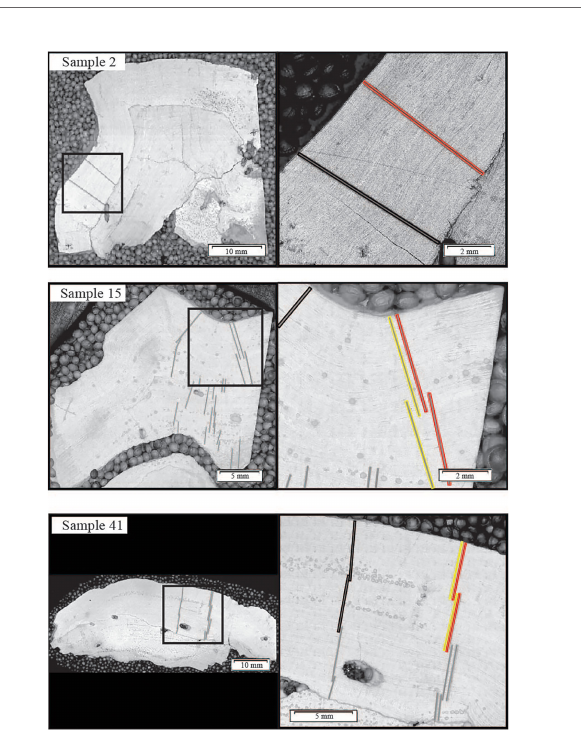
crossdating study. Transect 1 (Black); Transect 2 (Red); transect after bleaching the sample (Yellow). Boxes in images on the left are magni fi ed in images on the right. Laser measurement paths for samples 2 and 15 end at growth unconformity. Non-highlighted laser measurement paths for sample 41 not included in this study as no other samples could provide corresponding increments that could be used for